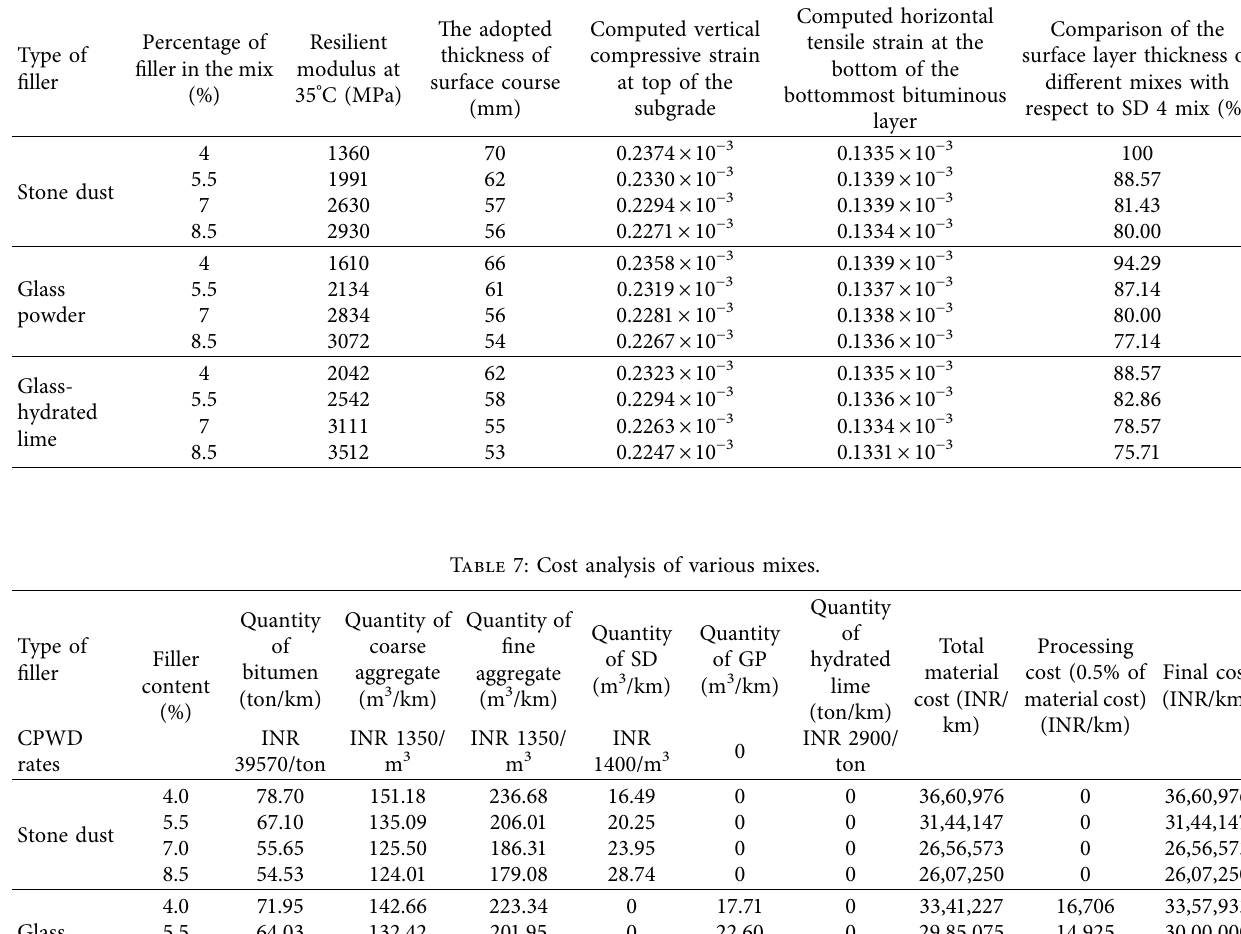
Table 6: The adopted thickness and computed strains (using IITPAVE).